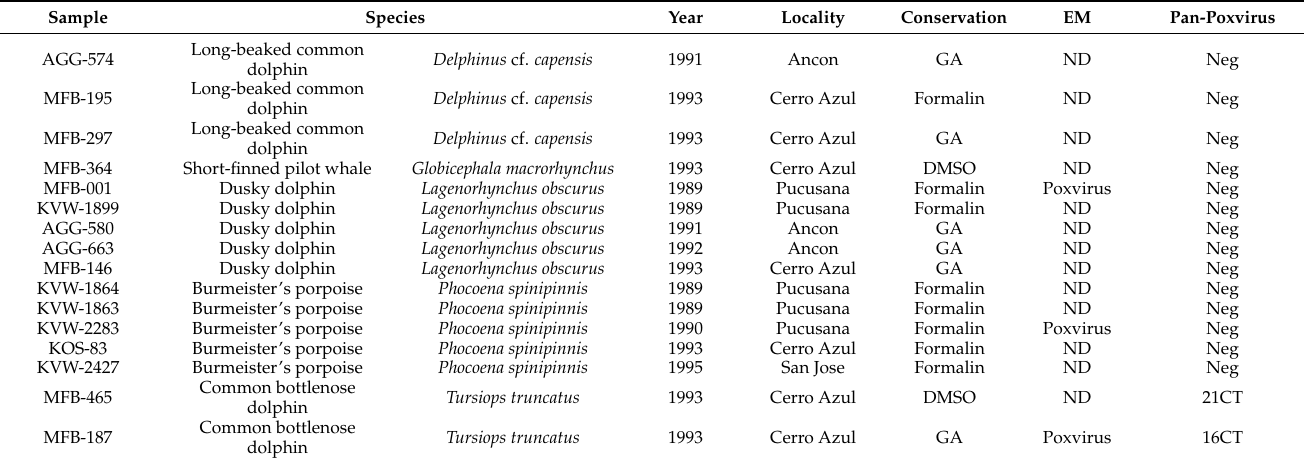
Table 1. Data on the cetaceans sampled for the tattoo skin lesions tested in this study, with the results of pan-poxvirus real-time PCR. Abbreviations: CT = cycle threshold, GA = glutaraldehyde, DMSO = dimethylsulfoxide, EM = electron microscopy, ND = not done. Species